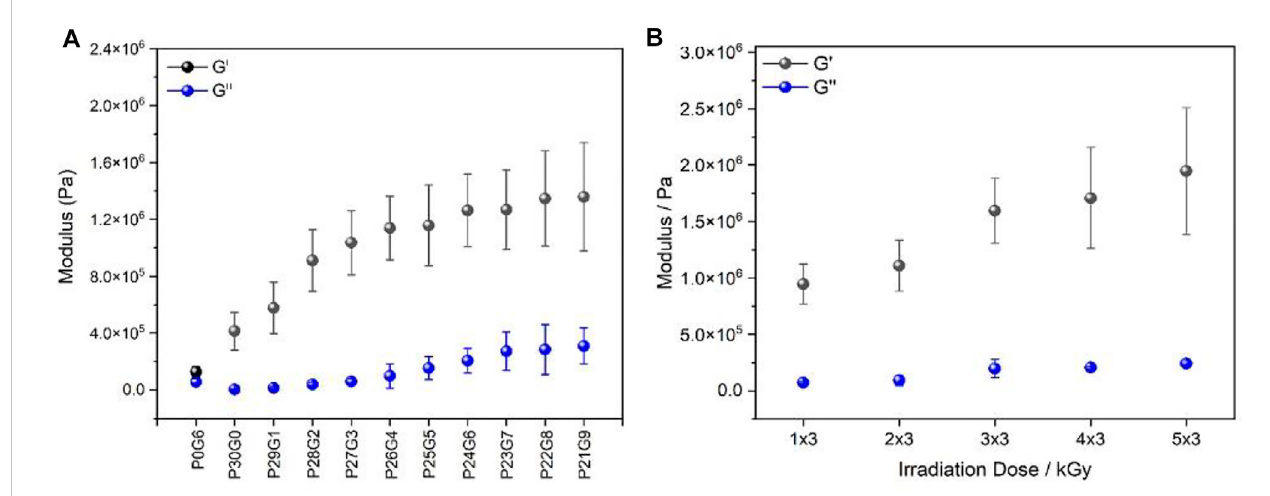
FIGURE 1 Rheological characteristics: storage modulus G ′ and loss modulus G ′′ of (A) different PEGDA/gelatin ratios of hybrid hydrogels irradiated with 6 kGy and (B) P26G4 hydrogel irradiated with different electron irradiation doses. Moduli were measured at a frequency of 1 Hz. Error bars indicate the standard deviation.